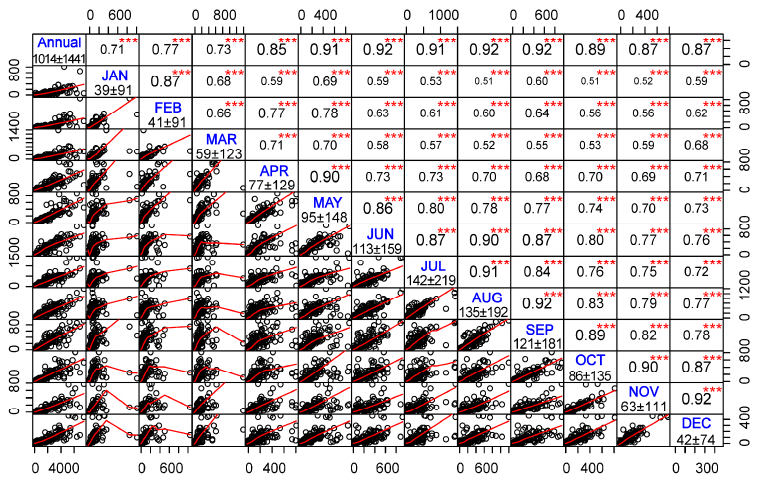
Figure 2. Correlation coefficient matrix of observed annual and monthly soil/ecosystem respiration. The diagonal panels represent the row and column heads, the numbers were the annual or monthly respiration (mean ± standard deviation, g CO 2 m − 2 yr − 1 or g CO 2 m − 2 month − 1 ). The numbers on x and y axis are respirations whose unit is g CO 2 m − 2 yr − 1 for annual emission and g CO 2 m − 2 month − 1 for monthly emission. The lower panels show the scatter plots (red lines are fitted lines of local regression) while the upper panels report the correlation coefficients. *** indicates significance at p < 0.001. The sample size is 330.